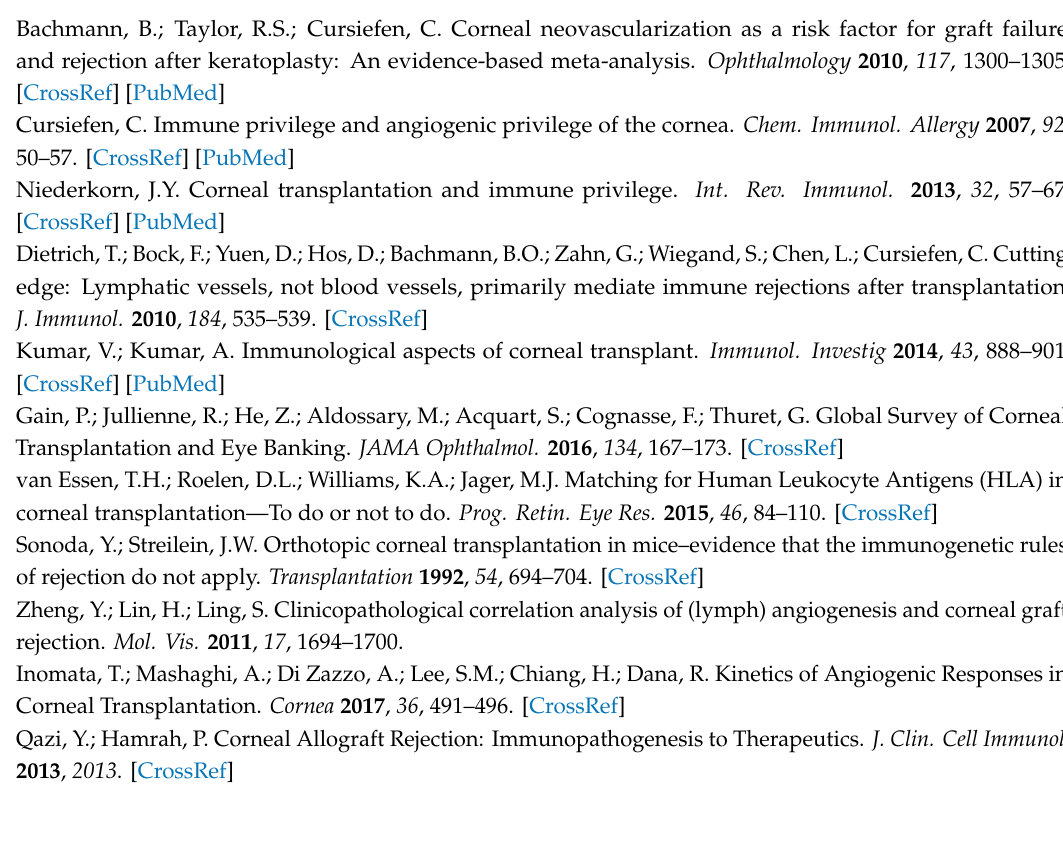
Figure S1: Increased stimulatory activity of VEGF-C / D trap treated antigen presenting cells. Stimulation response of draining lymph node immune cells (cells) to allogeneic stimulus of growth arrested C57BL / 6 cells (Bl6) and addition of IL2 (n.s.; n = 3, representative data from two independent